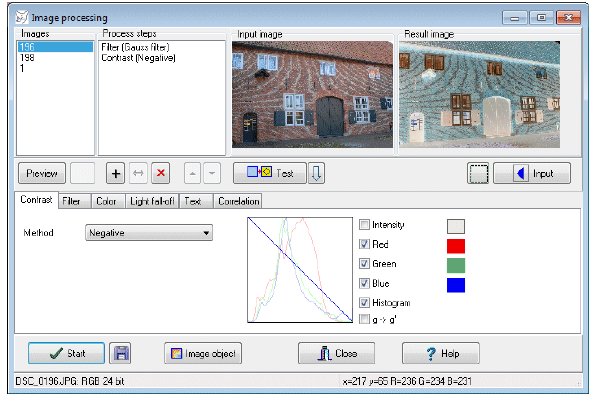
Figure 3: Image processing tool